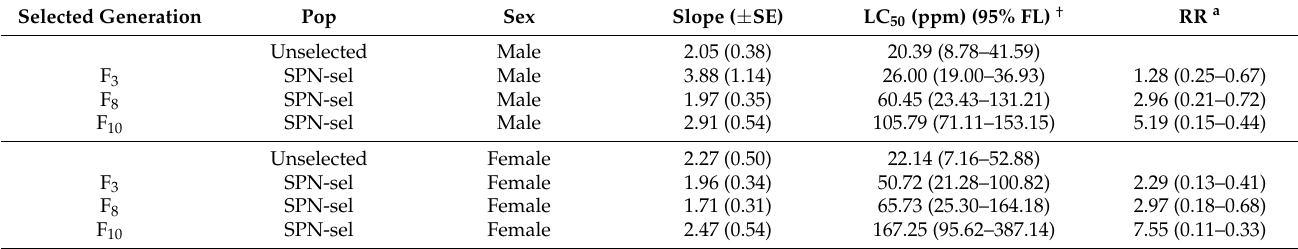
Table 1. Effect of spinosad residue on adult male and female D. suzukii from spinosad selected (SPN-sel) and unselected susceptible mixed field population.